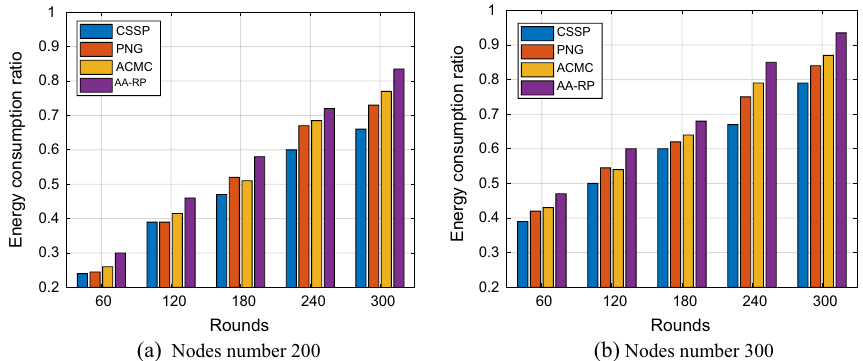
Fig. 6 Comparison of energy consumption for different number of sensor nodes. a Nodes number 200; b Nodes number 300